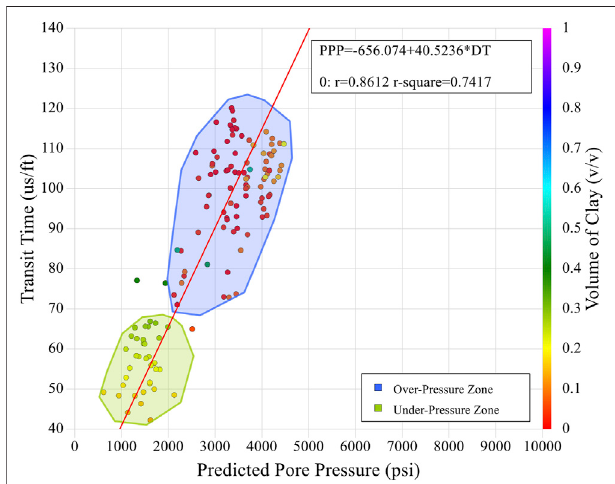
FIGURE 10 | Relationship of predicted pore pressure (PPP) and sonic transittime(DT)inQazian-1X.PorepressureispredictedforMurreeFormation using sonic log-based Eaton ’ s method, resulting in the identi fi cation of overpressure and underpressure zones. Regression analysis is performed after plotting PPP (x-axis) against DT (y-axis) with volume of clay (color bar), to validate the selection of Eaton ’ s index and normal compaction trend line. Green polygon represents the underpressure zone, and blue polygon represents overpressure zone. Regression curve (red line) shows the relationship of PPP and DT with r (0.8612) and r-squared (0.7417) values.